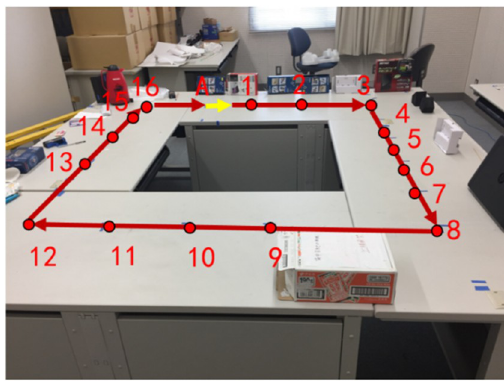
Figure 11. The designed route.